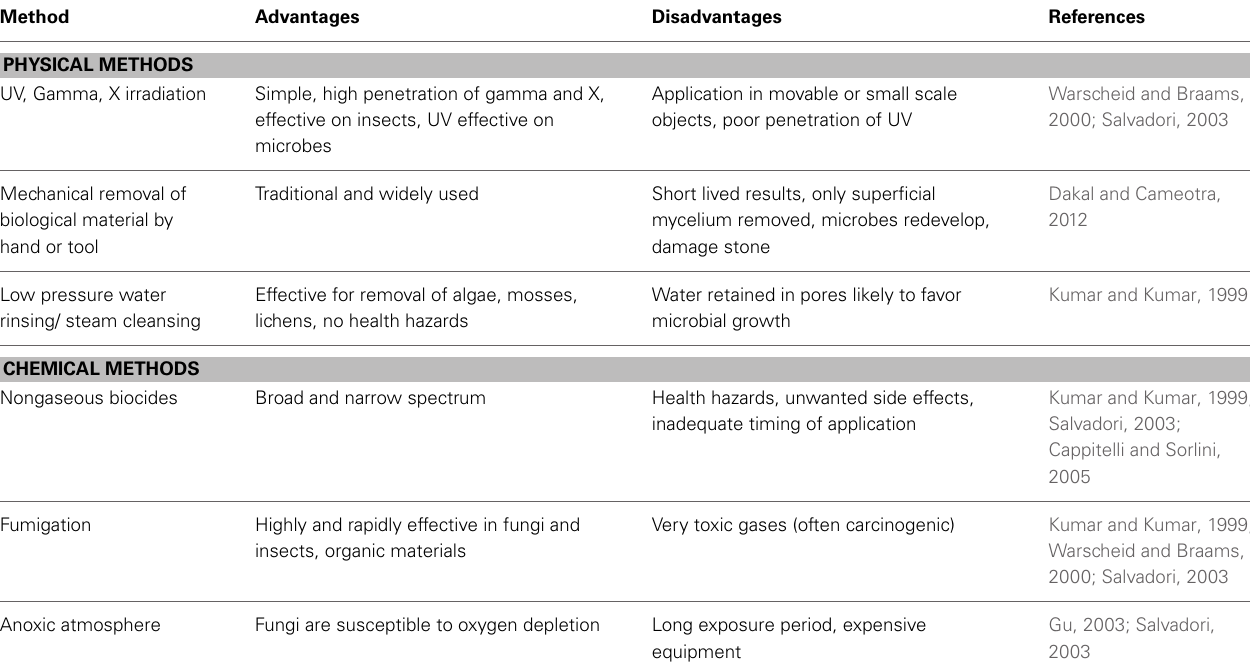
Table 1 | Methodologies for eradication of degradative agents of stone